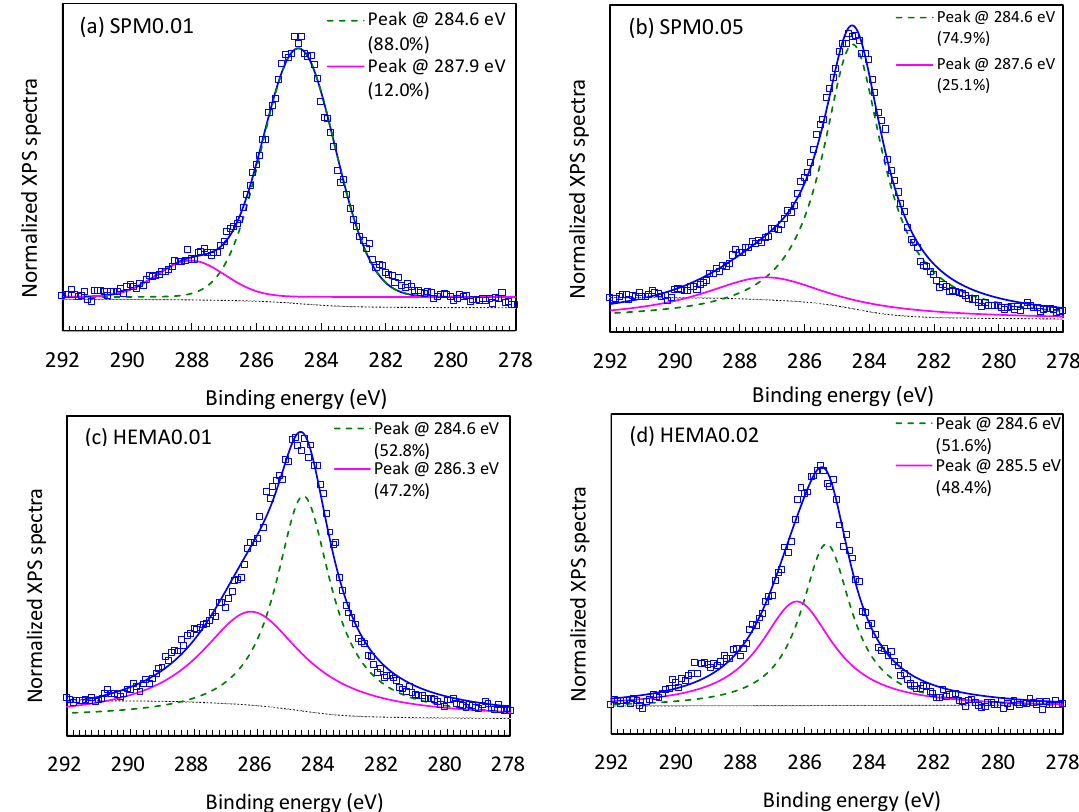
Table 1. Surface characteristics of the pristine and modified NF90 before and after silica fouling.